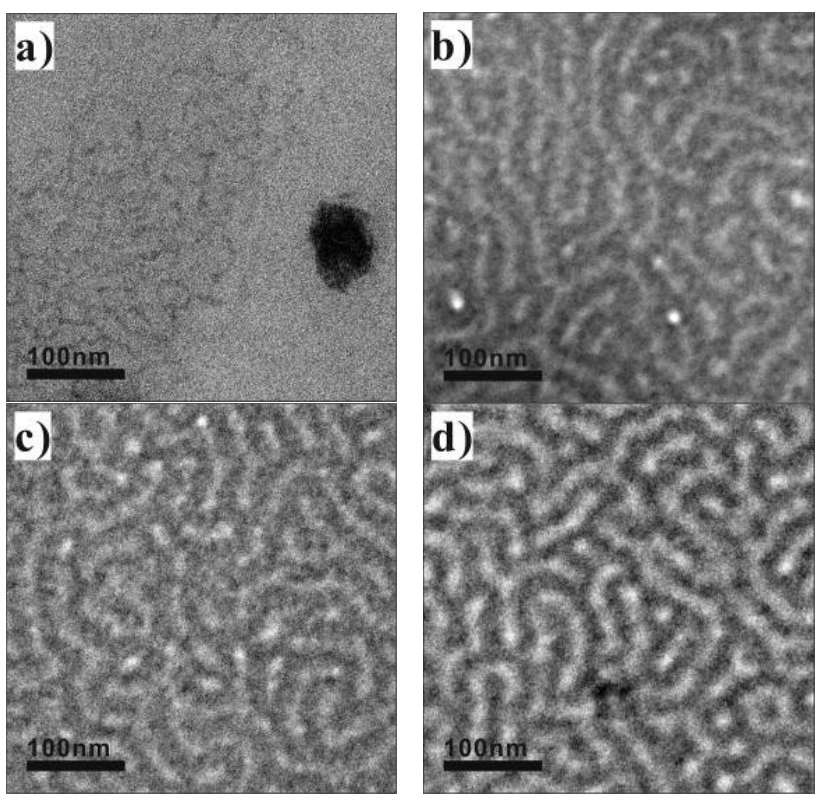
Figure 3. TEM images of PS- b -PEO membrane annealed at different condition. ( a ) 90 °C, 3 h; ( b ) 90 °C, 6 h; ( c ) 90 °C, 8 h; and ( d ) 90 °C, 10